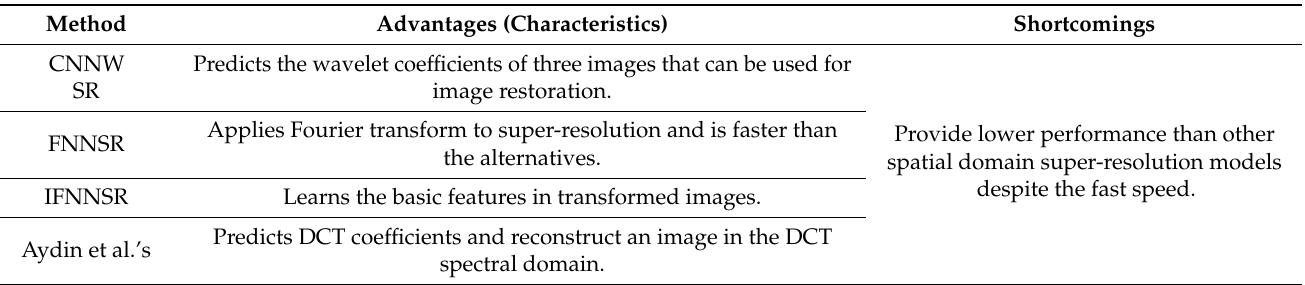
Table 3. Frequency domain super-resolution methods’ advantages and shortcomings. Method Advantages (Characteristics) Shortcomings CNNW Predicts the wavelet coefficients of three images that can be used for SR image restoration. Provide lower performance than other speed.FNNSR the spatial domain super-resolution models despite the fast